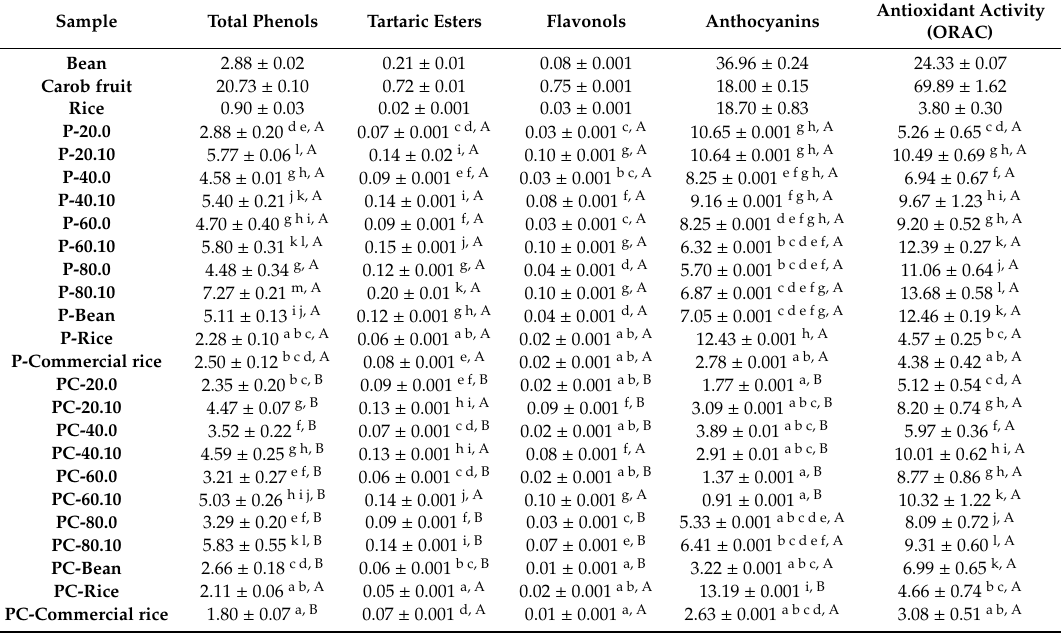
Table 5. Anthocyanins ( µ g C3GE / g dry weight), flavonols ( µ g QE / g dry weight), tartaric esters (mg CAE / g dry weight) and total phenols (mg ( + ) CE / g dry weight) content and the antioxidant activity ( µ mol Trolox / g dry weight) of the raw materials and the uncooked (P-) and cooked (PC-) fettuccine, as well as the commercial rice